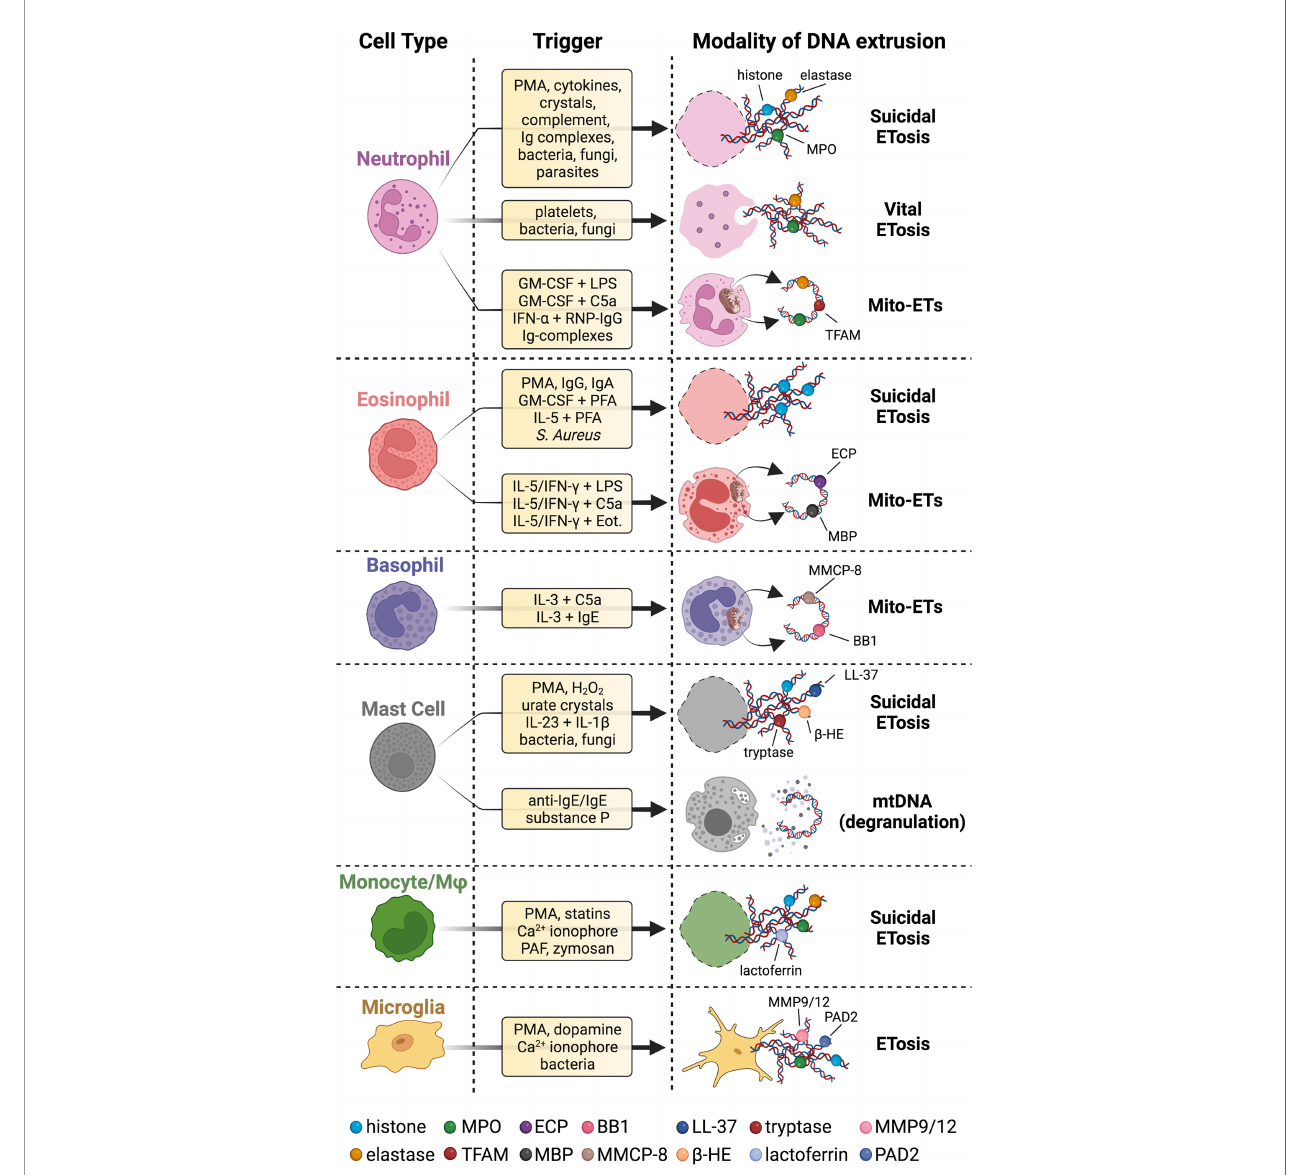
FIGURE 1 | Innate immune cells extrude different types of DNA strands and with several modalities. Upon stimulation with a wide range of stimuli, innate immune cells release chromatin fi bers coated with proteins in a cell death program called suicidal ETosis. Neutrophils can also proceed to ETs extrusion surviving as anucleated cytoplasts that can still exert immune effector functions (vital ETosis). Innate immune cells can even secrete ETs of mtDNA coated with cytoplasmic or granular proteins (Mito-ETs). Mast cells have been reported to release mtDNA concomitantly with degranulation. Microglial cells release ETs, but it is not clear whether this process is associated with cell death. Speci fi c references to different ETs stimuli and types are given in the body of the text. BB1 = basogranulin; b -HE = b -hexosaminidase; Eot. = eotaxin; MMCP-8 = mouse mast cell protease 8. Created with